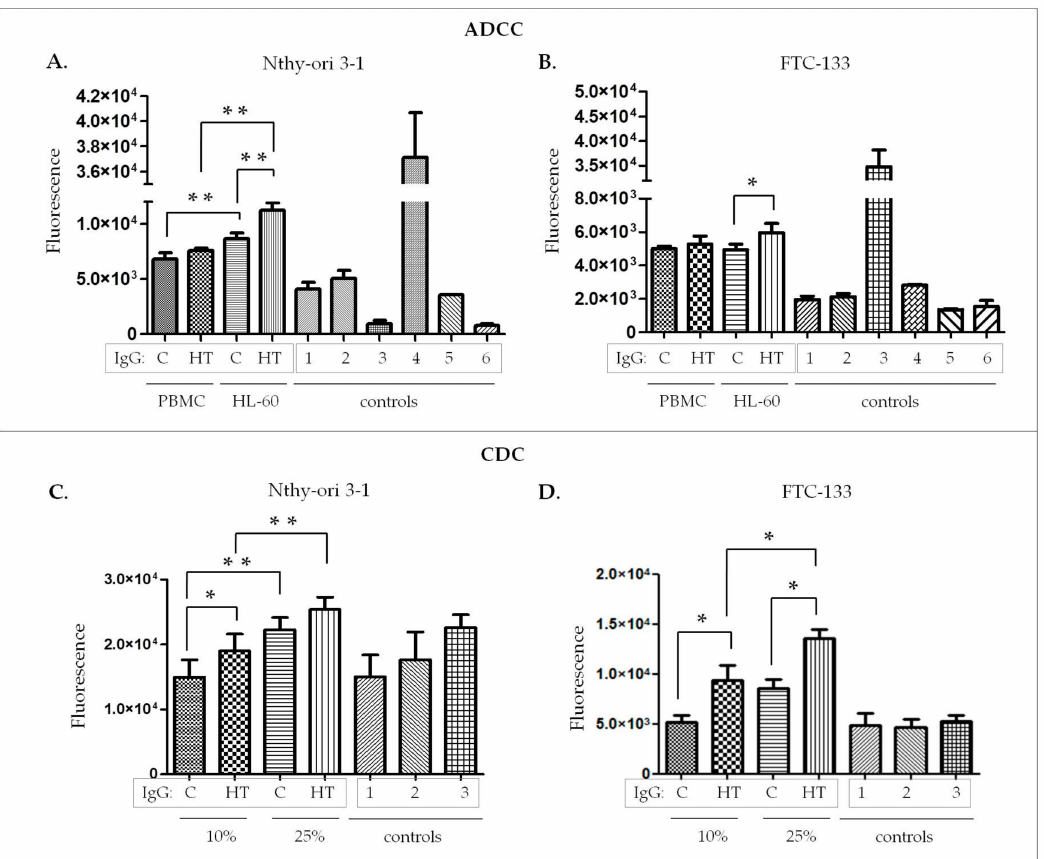
Figure 4. Nthy-ori 3-1 and FTC-133 target cell death, expressed as fluorescence intensity determined in ADCC and CDC models. ( A ) Nthy-ori 3-1 and ( B ) FTC-133 cell lysis triggered by IgG isolated from Hashimoto’s thyroiditis patients (HT) and healthy donors ( C , control) and mediated by peripheral blood mononuclear cells (PBMC) and the HL-60 human promyelotic leukemia cell line in the ADCC model. ( C ) Nthy-ori 3-1 and ( D ) FTC-133 cell lysis triggered by C and HT IgG in the presence of 10% and 25% serum from healthy donors in the CDC model. In each experiment, a set of controls was prepared. The following controls were used: in the ADCC model: (1) target cells incubated with C IgG, (2) target cells incubated with HT IgG, (3) untreated target cells, (4) whole target cells lysed, (5) HL-60 cells, (6) PBMC; in the CDC model: (1) target cells, (2) target cells incubated with 10% serum, (3) target cells incubated with 25% serum. The data are shown as means ± SD. The di ff erences between the experimental variants were analyzed statistically by two-way ANOVA with the post hoc Tukey test (* p ≤ 0.05, ** p ≤